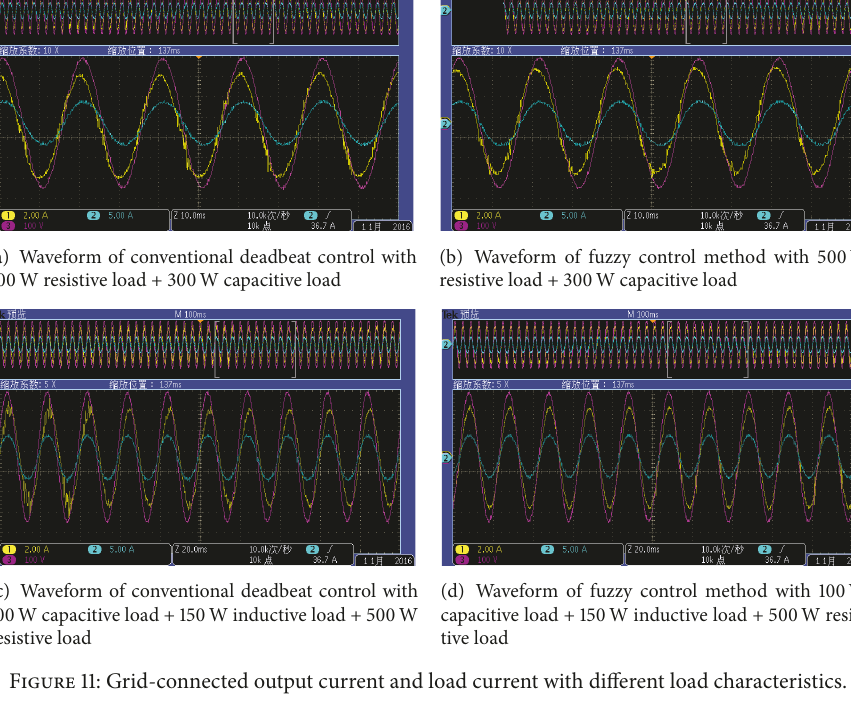
Figure 11: Grid-connected output current and load current with different load